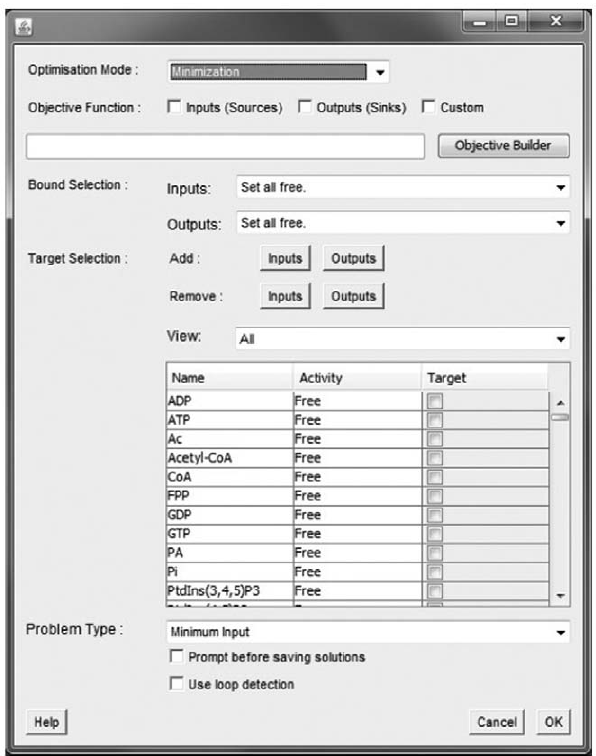
Figure 3. The main window of PATHLOGIC-S provides problem instantiation options. Custom objectives are supported through an objective builder, along with several presets. Target specification and activity settings are through the table presented, which can be restricted to show only system inputs and system outputs. At present, PATHLOGIC-S offers two methods of curation - one at the point of execution through dialog boxes, and one prior to execution through Cytoscape. Once the user clicks OK, the software executes